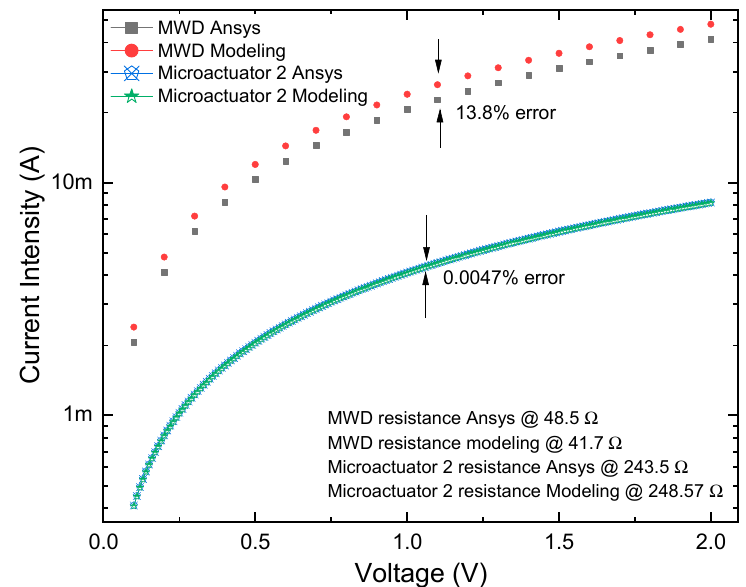
Figure 13. Behavior of current vs. voltage by numeric and modeling results.